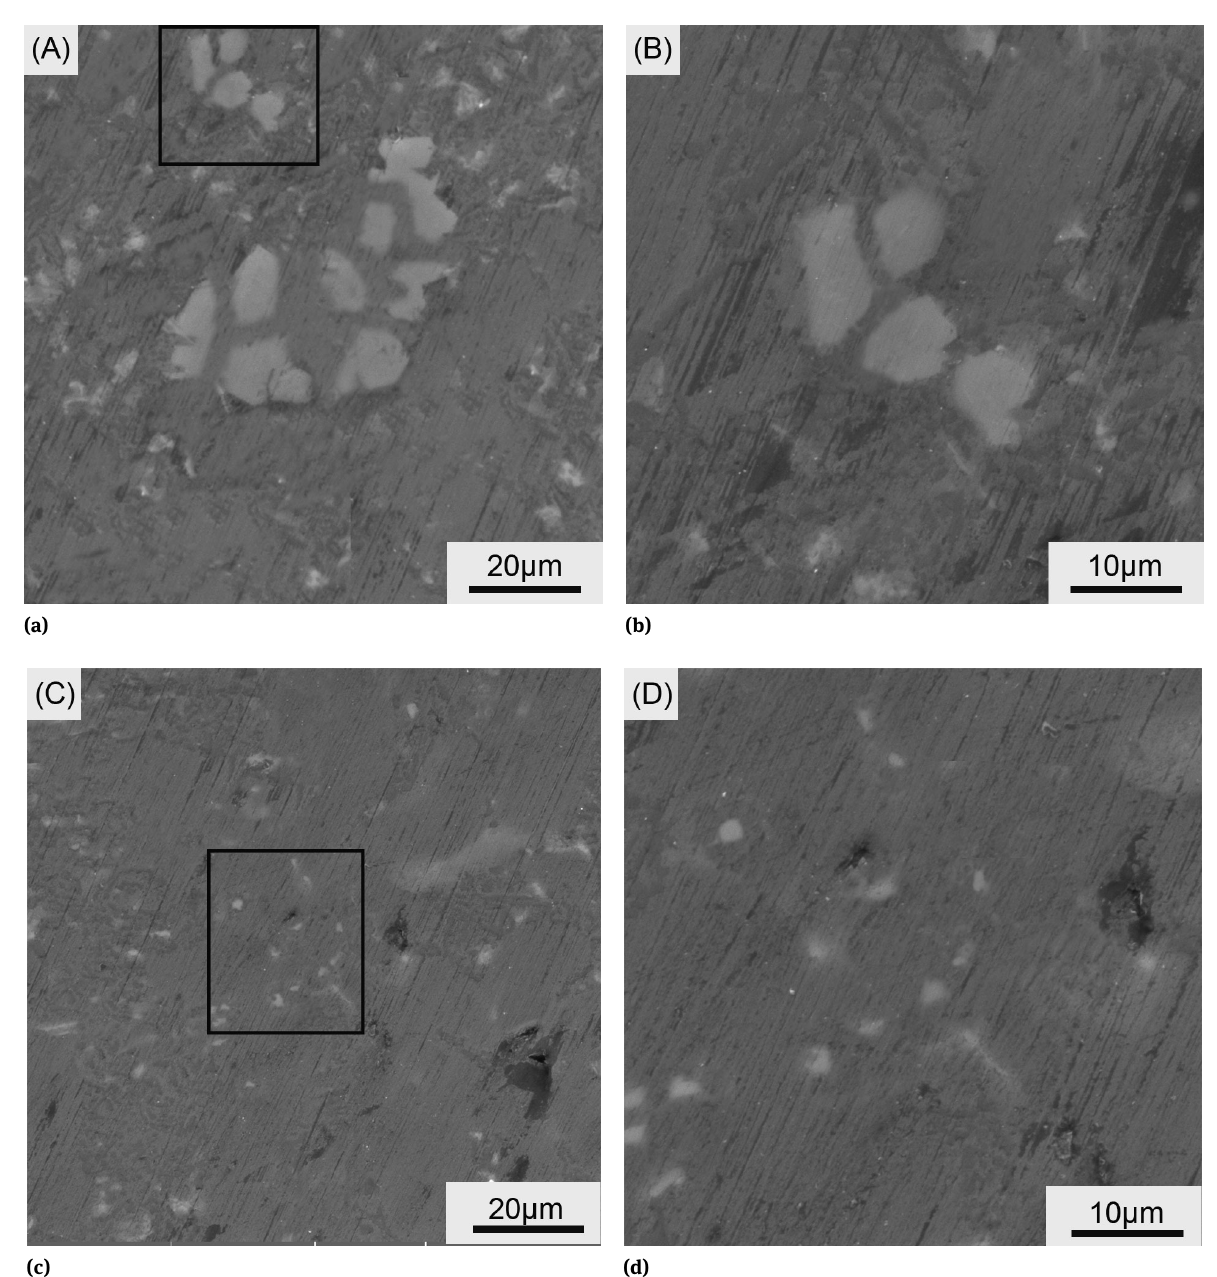
Figure 5: SEM images of the composites (a) in low magnification without ultrasonic assistance; (b) in high magnification without ultrasonic assistance; (c) in low magnification with ultrasonic assistance; (d) in high magnification with ultrasonic